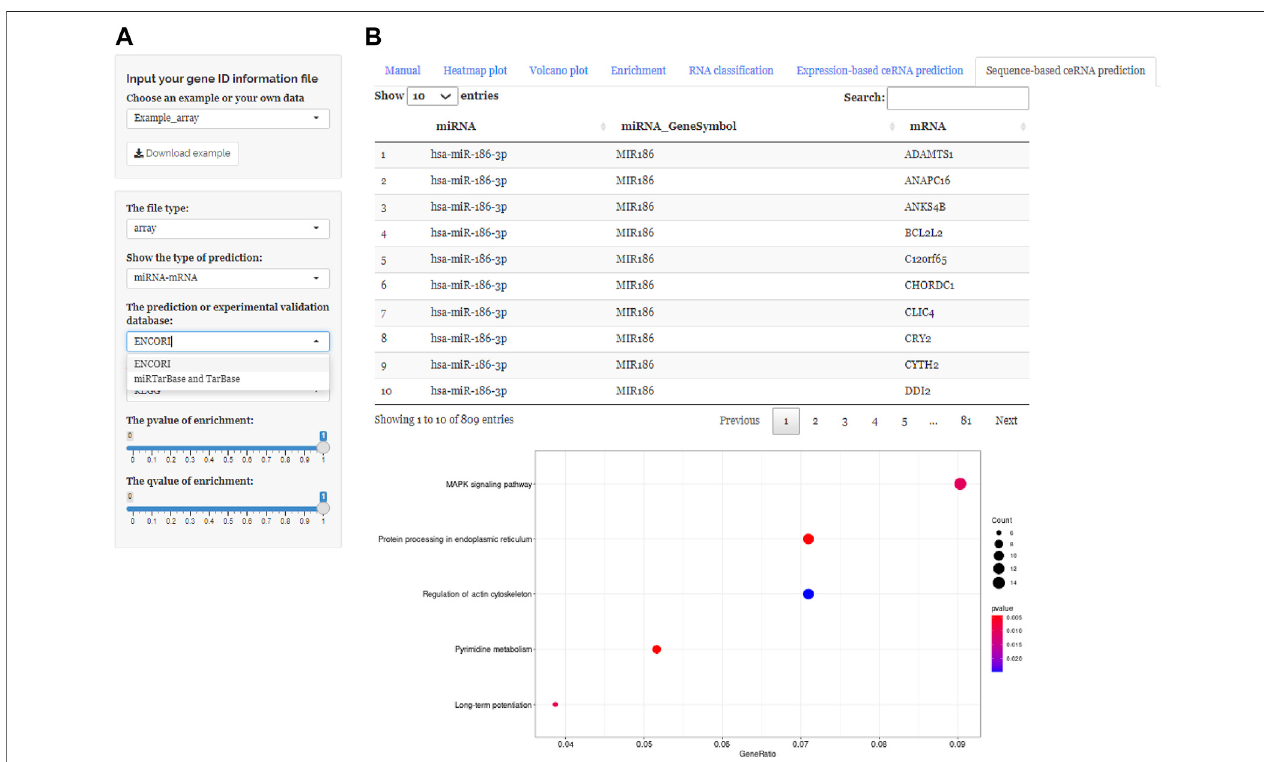
FIGURE 5 | Using ceRNAshiny to generate “ Sequence-based ceRNA prediction. ” (A) Panels to adjust parameters. (B) The generated database prediction and its enrichment results based on databases using the template